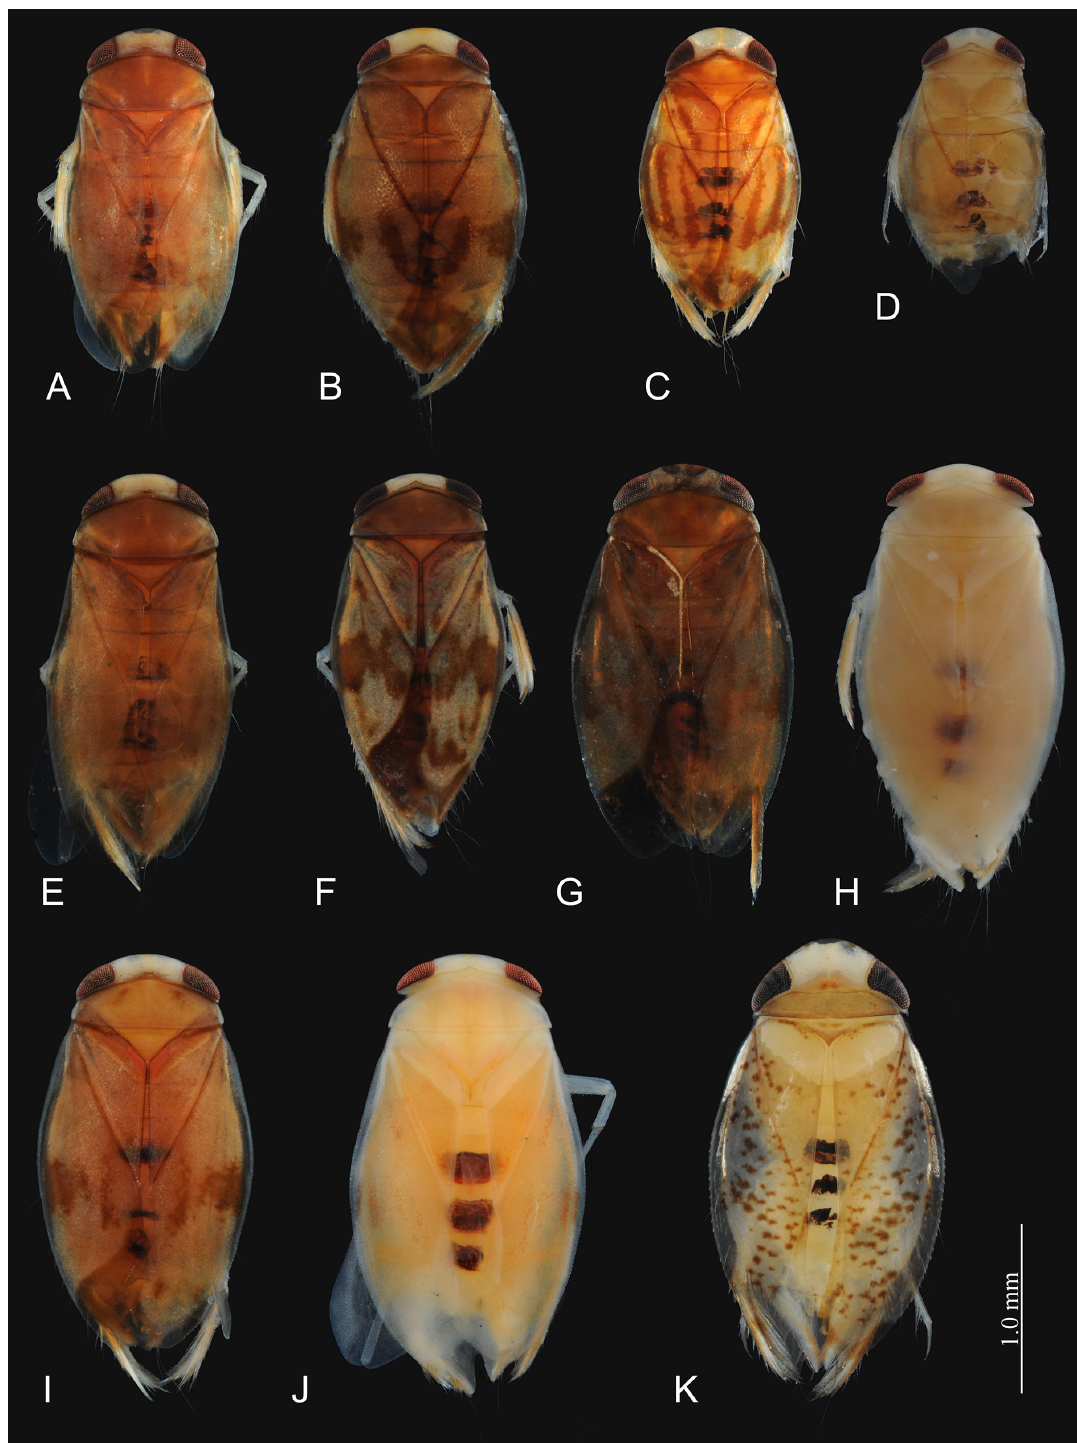
Fig. 13. Habitus photos of species of Micronecta Kirkaldy, 1897, ♂♂. A . M. ornitheia Nieser, Chen & Yang, 2005 (ZVNU). B . M. tuwanoni Nieser, Chen, Leksawasdi, Thanyakam & Duangsupa, 2004 (ZVNU). C–D . M. clavata sp. nov., two colour forms (ZVNU), C = holotype. E . M. sinuata sp. nov., holotype (ZVNU). F . M. undulata sp. nov., holotype (ZVNU). G–H . M. nieseri sp. nov., two colour forms (ZVNU), G = holotype. I–J . M. pingae sp. nov., two colour forms (ZVNU), I = holotype. K . M. haliploides Horváth, 1904 (ZVNU). All to the same